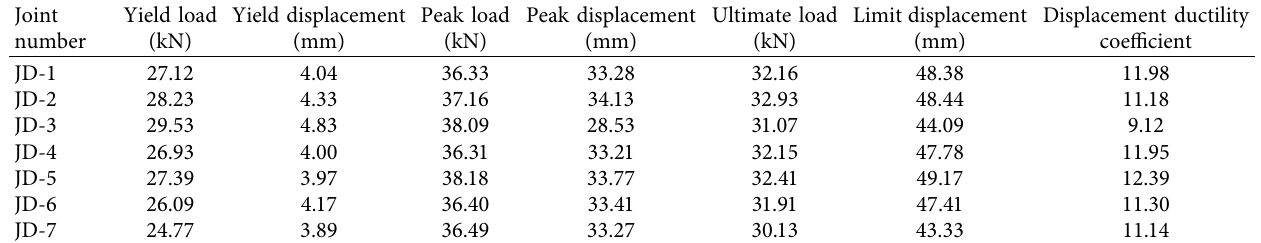
Table 10: The eigenvalues of the skeleton